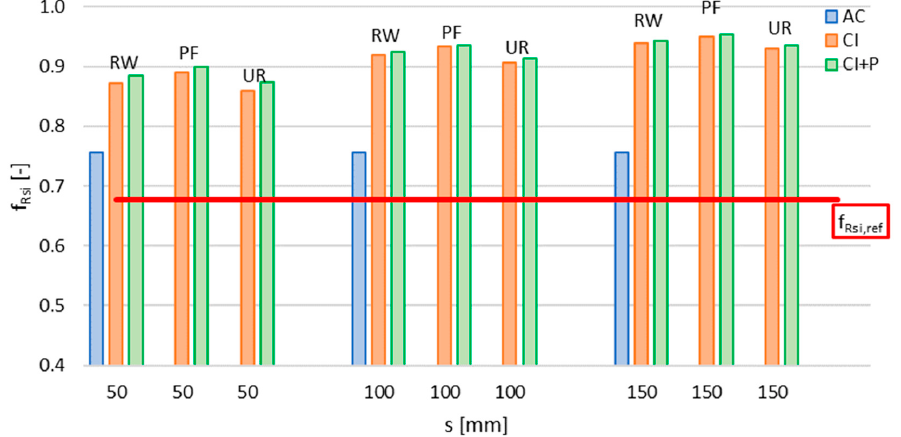
Figure 7. Temperature factor f Rsi .